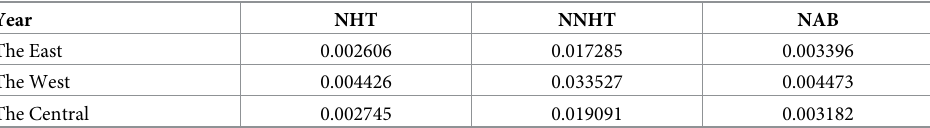
Table 7. The shadow price of inputs by regions.